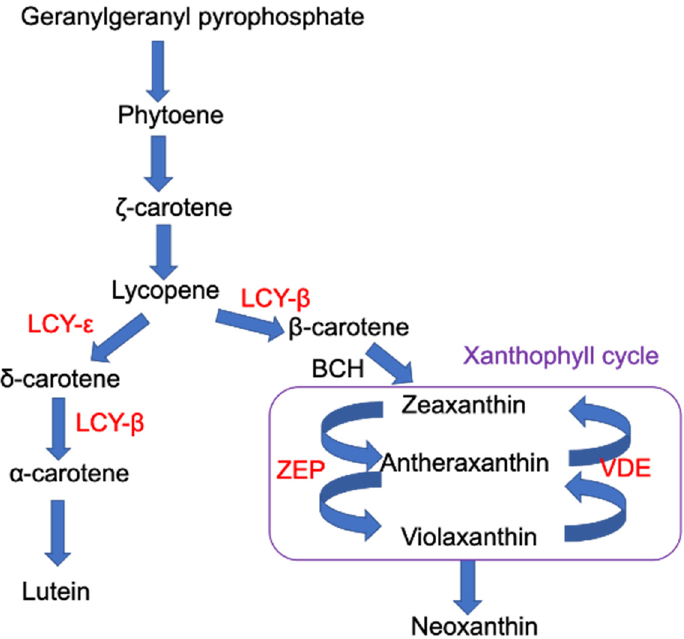
Figure 1. Simplified plant carotenoid biosynthetic pathway. Text in red refers to the enzymes LCY- ε (lycopene epsilon cyclase), LCY- β (lycopene beta cyclase), BCH (carotenoid beta-ring hydroxylase), ZEP (zeaxanthin epoxidase), VDE (violaxanthin de-epoxidase)) that catalyse various steps of the carotenoid pathway. Mutants in several of these genes were used in this study as specified in Table 1 (ZEP, aba1; LCY- ε , lut1 ; VDE, npq1-2 ; LCY- β and VDE, szl1-1npq1-2 ).